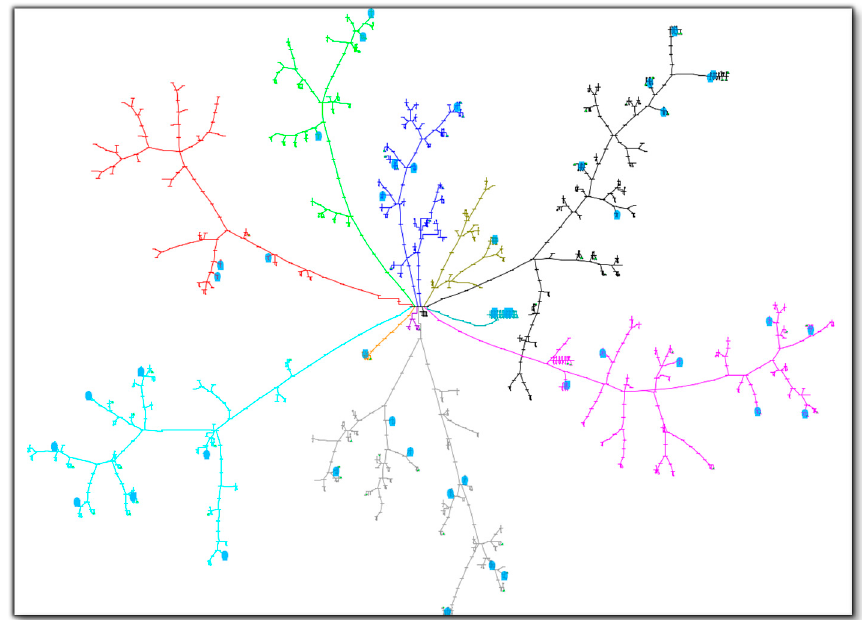
Figure A5. Use case 2—Location of PVs.